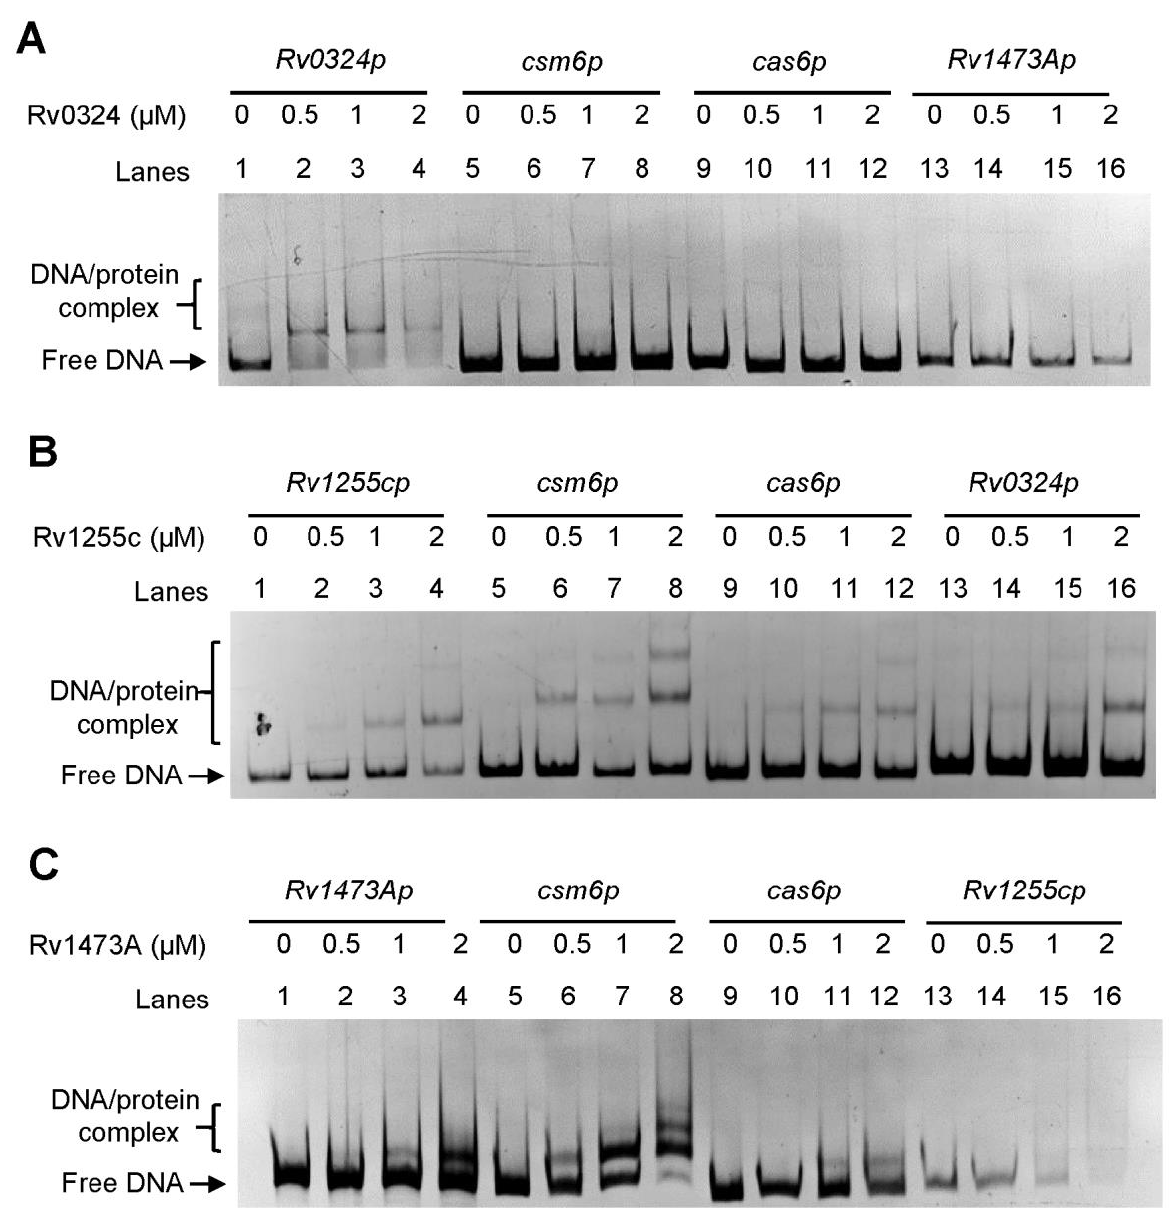
Figure 2. EMSA of binding of transcription factors ( A ) Rv0324, ( B ) Rv1255c, and ( C ) Rv1473A to their own promoters and CRISPR system promoters. The 100 ng target gene csm6 and 100 ng cas6 promoters were co-incubated with different concentrations (0 –2 μM) of transcription factors. The DNA-protein complex is indicated with square brackets.